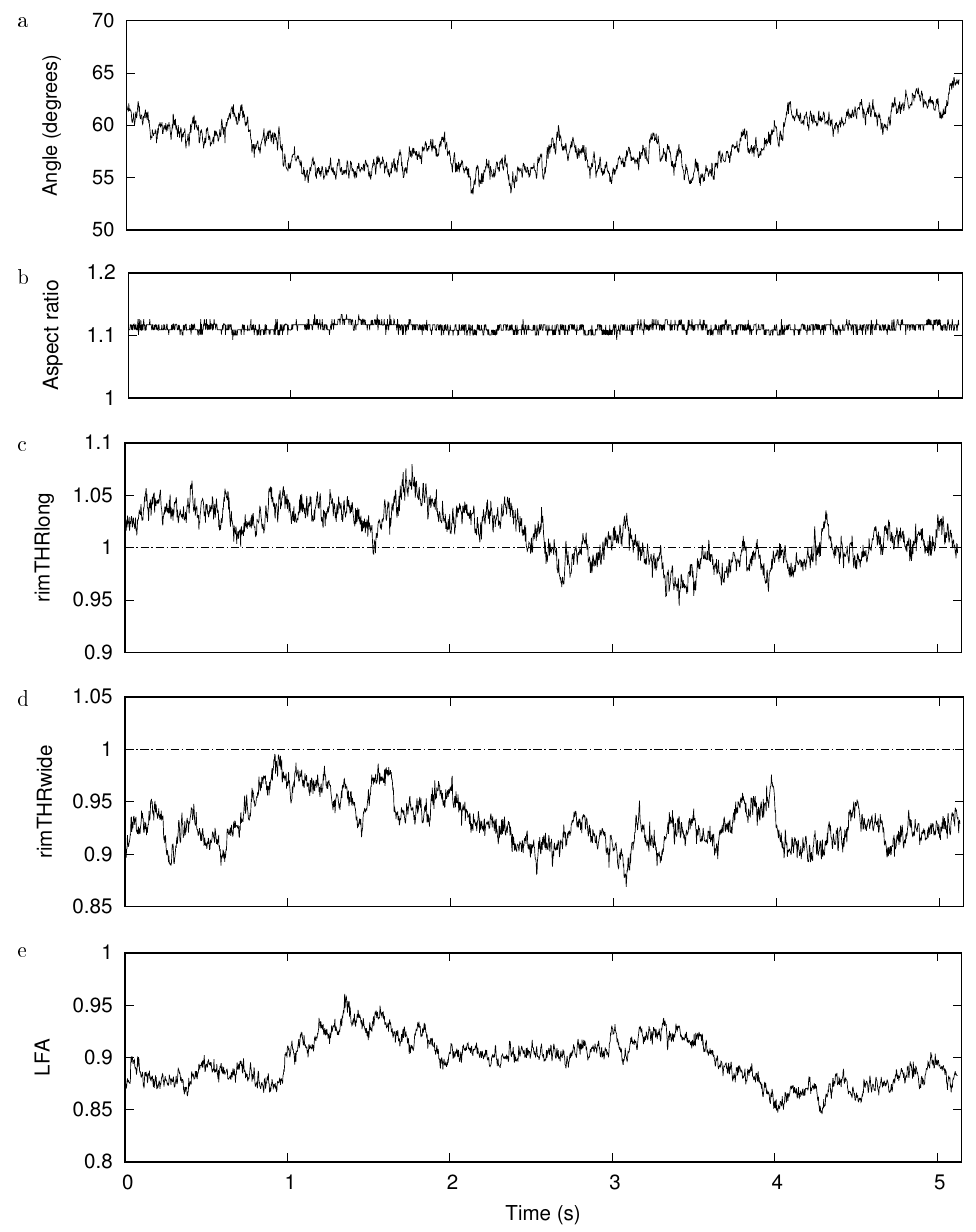
Figure 11. Time series of selected quantities. ( a ): angle of the major axis with the horizontal. Figure11:Timeseriesofsele tedquantities.a:angleofthemajoraxiswiththehorizontal.b:aspe t ( b ): aspect ratio. ( c , d ): Ratio between rim thicknesses at the two opposite ends of the major and minor ratio. axis, respectively. In contrast to the definitions in Equations (7) and (8), it is here the ratio of two individual thicknesses. ( e ): LFA. For details see